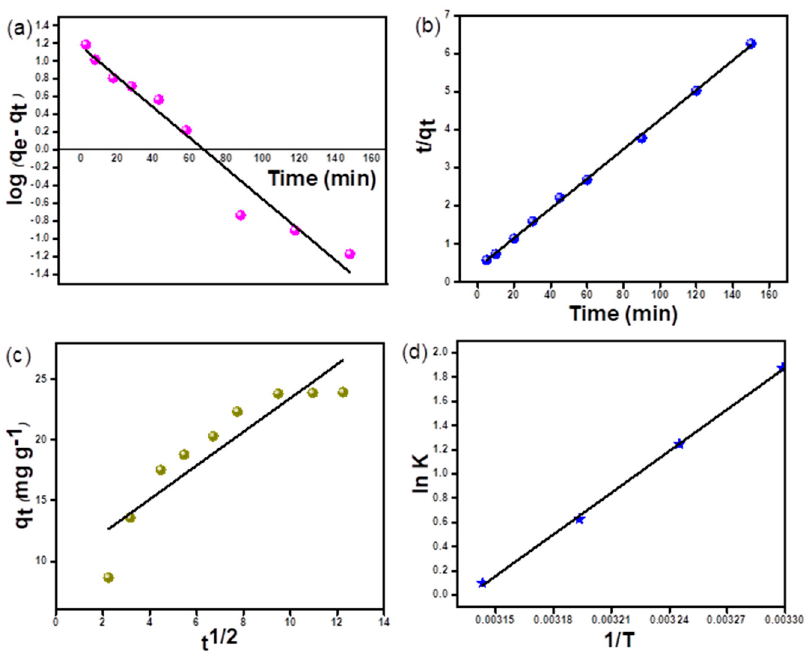
Figure 9. RO 16 adsorption kinetics plot ( a ) PFO kinetic plot ( b ) PSO kinetic plot ( c ) IPD kinetic plot ( d ) vant Hoff plot. Table 1. Kinetic Parameters for RO 16 dye adsorption.